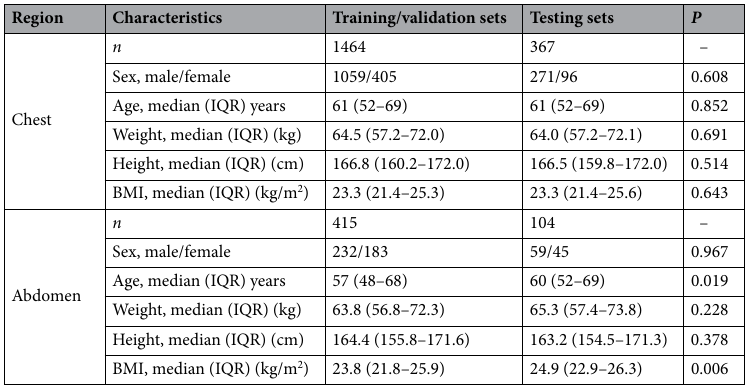
Table 1. Summary of baseline characteristics of study subjects. BMI , body mass index; IQR , interquartile range.